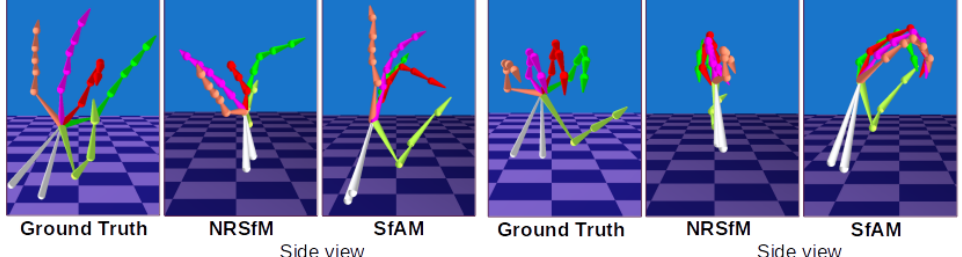
Figure 7. Comparison of our SfAM to NRSfM [11] on an NYU hand pose dataset